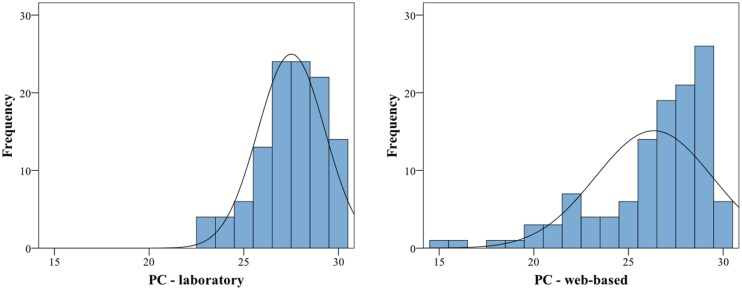
Histograms of proportion correct for the Memory subtest for laboratory (left) and web-based group (right). Both exhibit a significant negative skew (the web-based group additionally exhibits a significant kurtosis), thus are deviating from a normal distribution. For statistics, cf. Table 6.